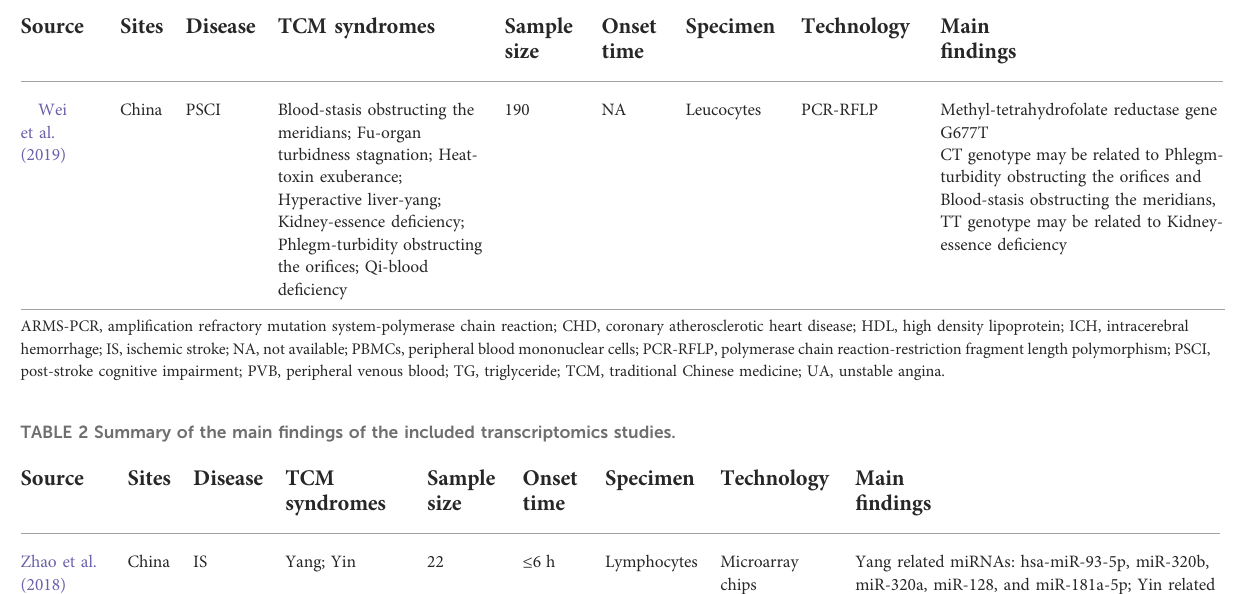
TABLE 1 ( Continued ) Summary of the main fi ndings of the included genomics studies.